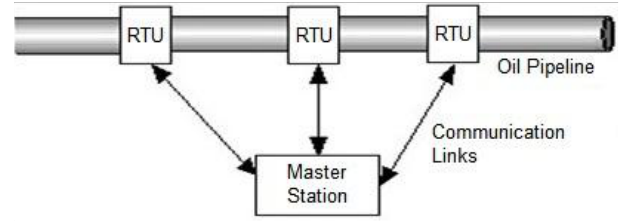
Figure 15. Typical oil pipeline control system.